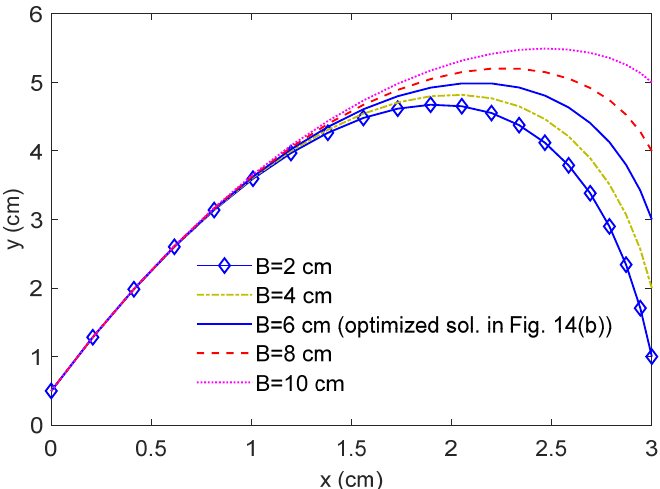
Figure 15. The profiles of Bézier plates with various B values.